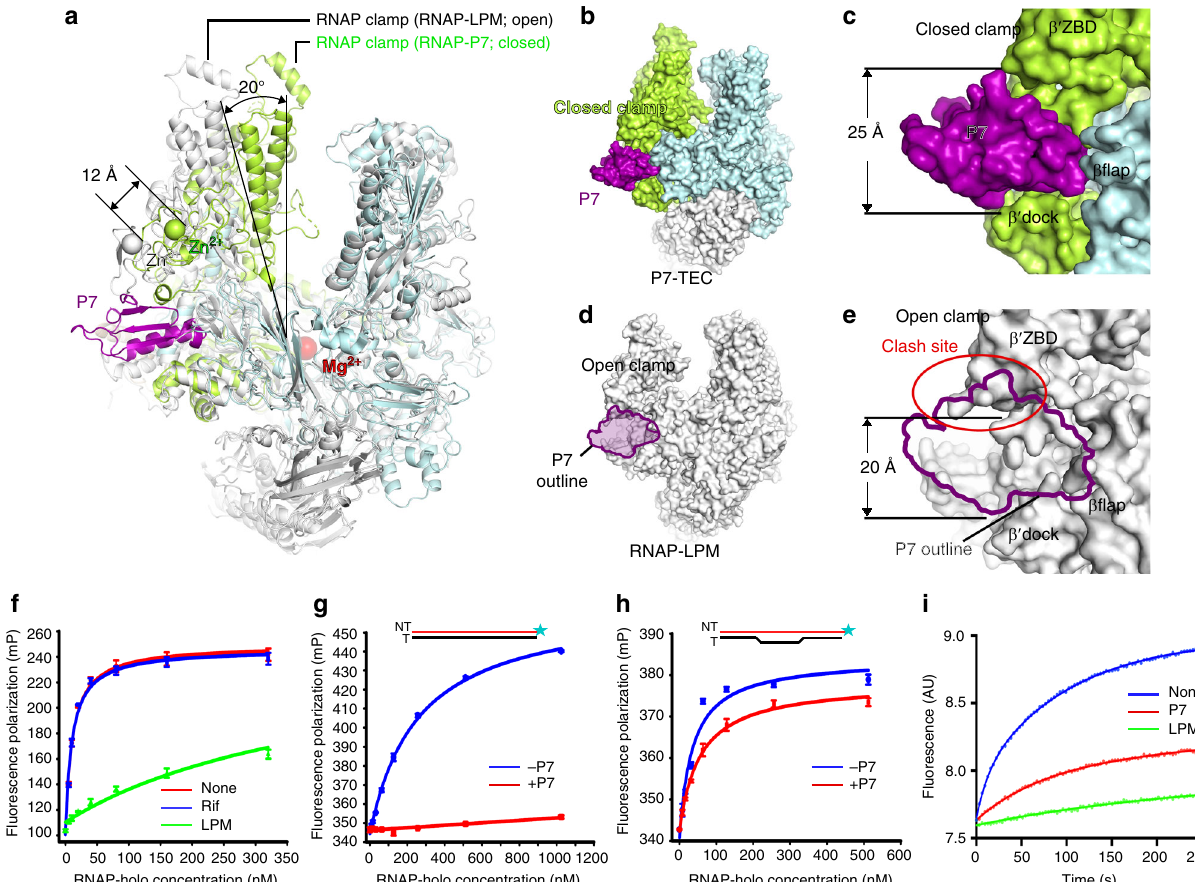
Fig. 5 P7 locks RNAP clamp in the closed conformation. a Structural superimposition between Mtb RNAP-Lipiarmycin (PDB: 6FBV) with P7-NusA-TEC shows a 20° swinging of the clamp domain and a concomitant 12-Å movement of β ′ ZBD from the closed (P7-NusA-TEC) to open (RNAP-LPM) conformation of the clamp domain. b P7 inserts into the RNA exit channel and locks the clamp in the closed-conformation in the structure of P7-NusA-TEC. c The close-up presentation of the P7 binding site with a diameter of 25 Å. d P7 is not compatible with the open-clamp conformation. The P7 outline superposed onto the structure of Mtb RNAP-Lipiarmycin highlights the crushed P7 binding site in the open-clamp conformation. e The 12-Å shift of β ′ ZBD crushes into the P7 binding site and reduces the P7 binding site to a diameter of 20 Å. f Lipiarmycin (LPM) signi fi cantly inhibits the binding of P7 to RNAP, while rifampicin shows no effect in a FP assay. g P7 almost completely inhibits promoter dsDNA binding and isomerization by RNAP in a FP experiment. h P7 has little effect on the binding of pre-melted promoter of RNAP. i P7 inhibits promoter melting in a real-time stopped- fl ow assay. The experiments were repeated in triplicate, and the data were presented as mean±S.E.M. The source data of Fig. 5f – i are provided in the Source Data fi